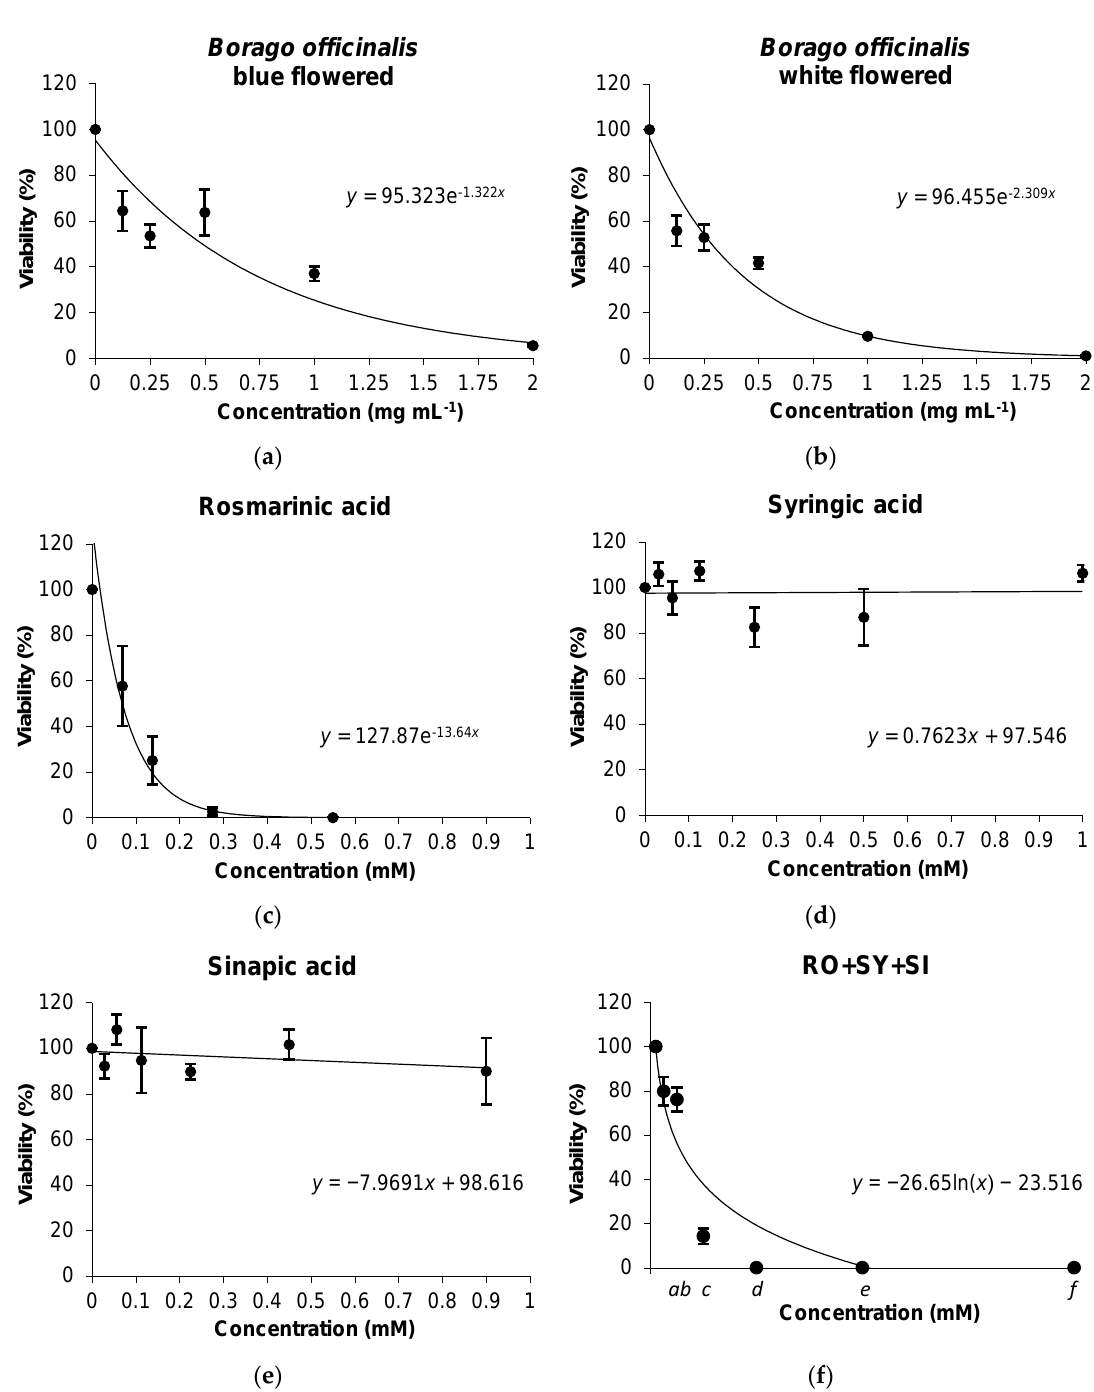
Figure 3. Survival of HL-60 cultures treated with different concentrations of: Borago officinalis ( a ) blue flowered (BF) and ( b ) white flowered (WF) plant material; and bioactive compounds: ( c ) RO; ( d ) SY; ( e ) SI and ( f ) mixture (RO + SY + SI; italic letters from a – f correspond to the concentrations respectively assayed for each single compound once their mixture is assayed.). Survival estimated regressions are plotted as percentages with respect to the control counted from at least three independent experiments (mean ˘